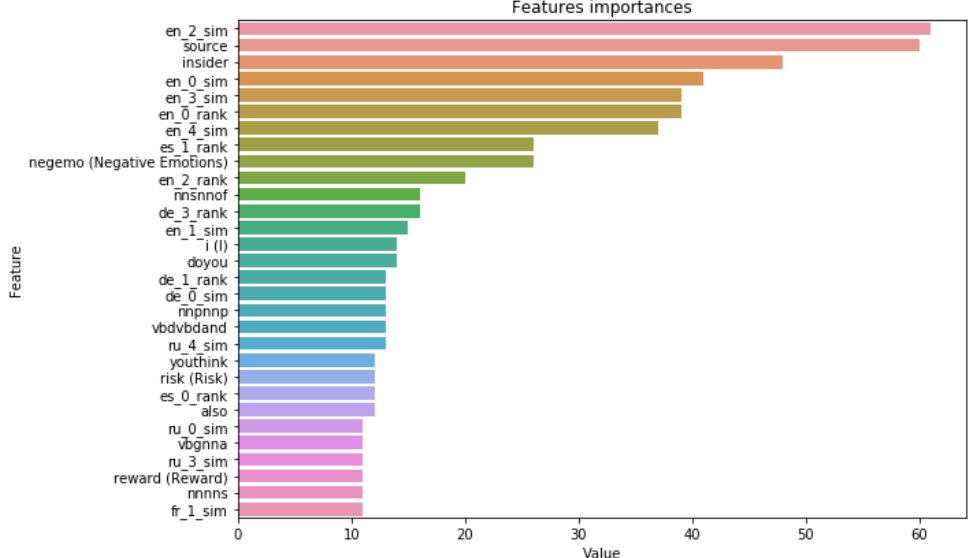
Figure A1. Top 30 feature importances of the best model for the celebrity dataset: LightGBM model based on all linguistic + CE Emb. + Rank feature set.